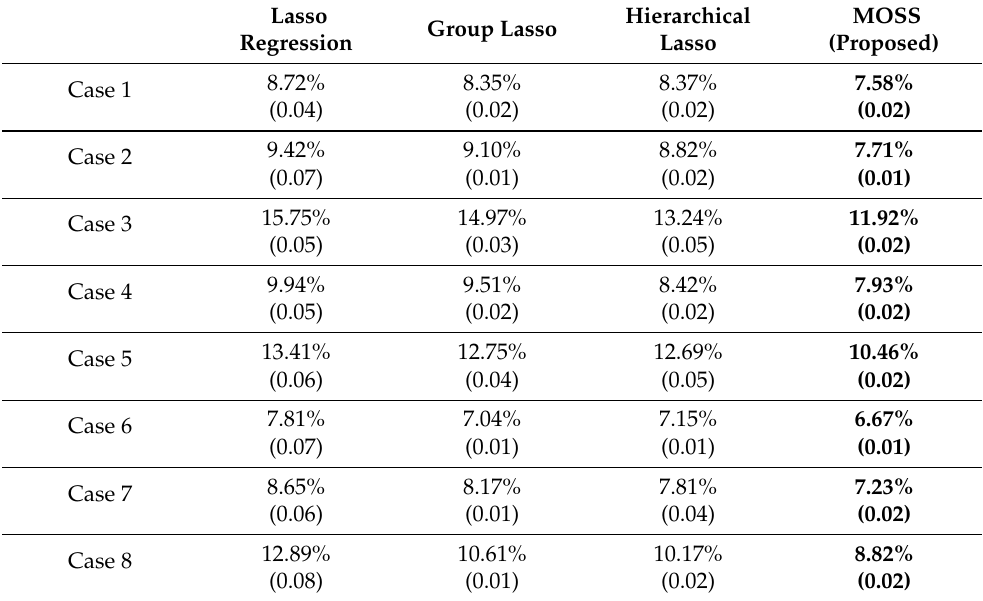
Table 3. Normalized Root-Mean-Square Error (RMSE) (Standard Error) of Each Simulation Case.